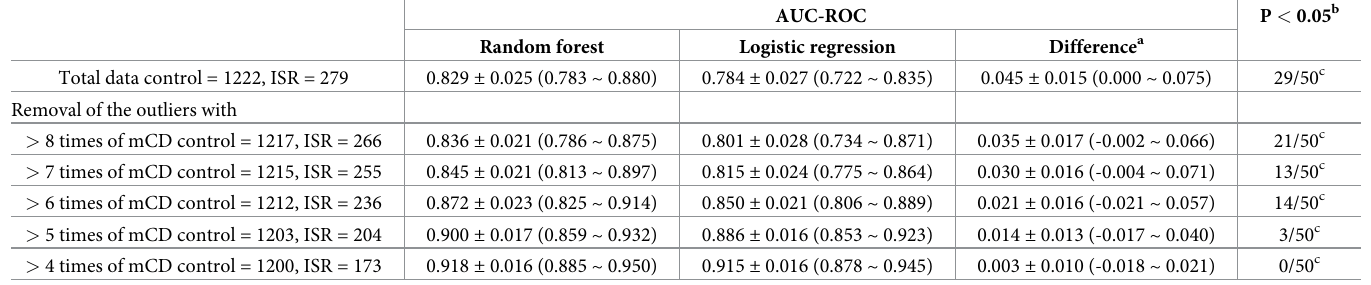
Table 3. Robustness test by sequentially removing the